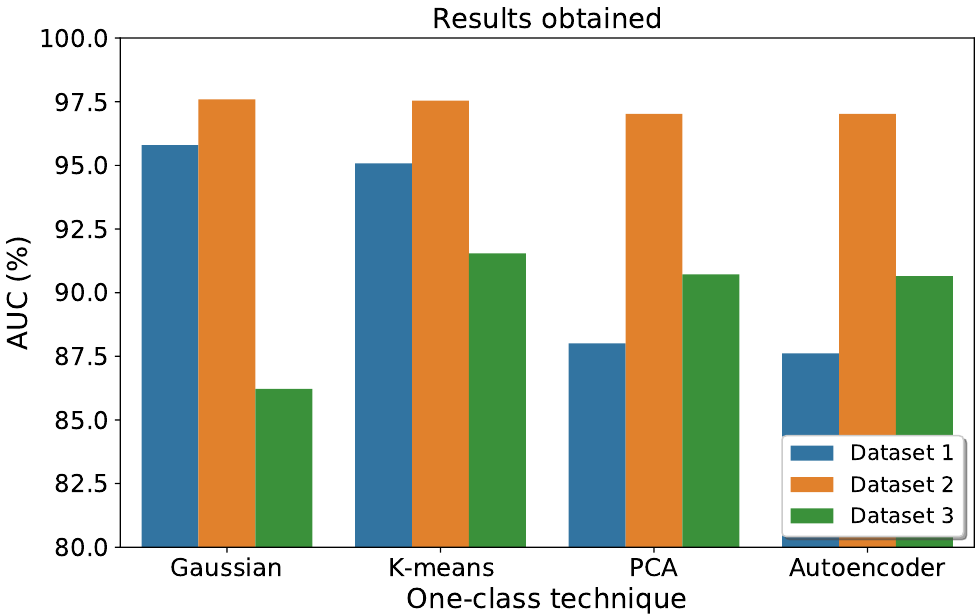
Figure 5. Comparison of the performance of each technique in each